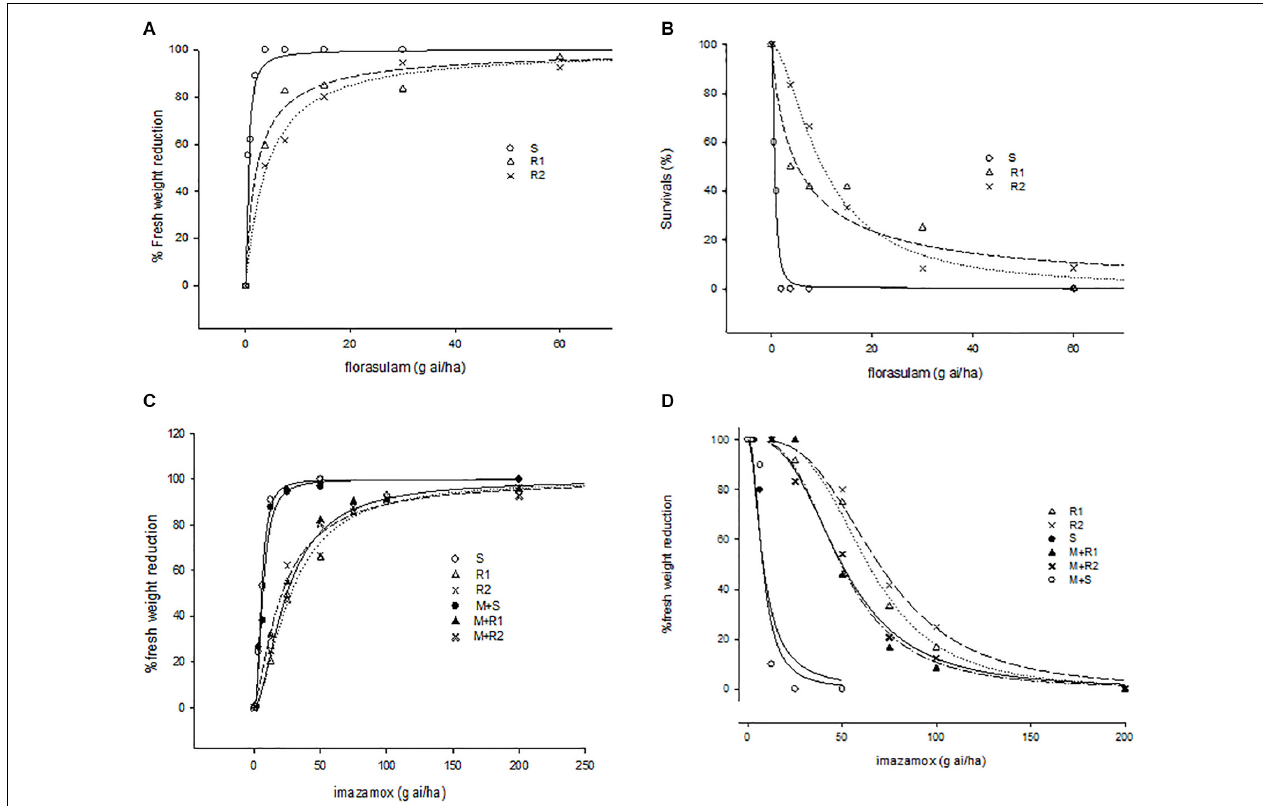
FIGURE 1 | Response of fresh weight and survivals of susceptible and resistant populations of G. coronaria to different concentrations of florasulam (A,B) and imazamox (C,D) .